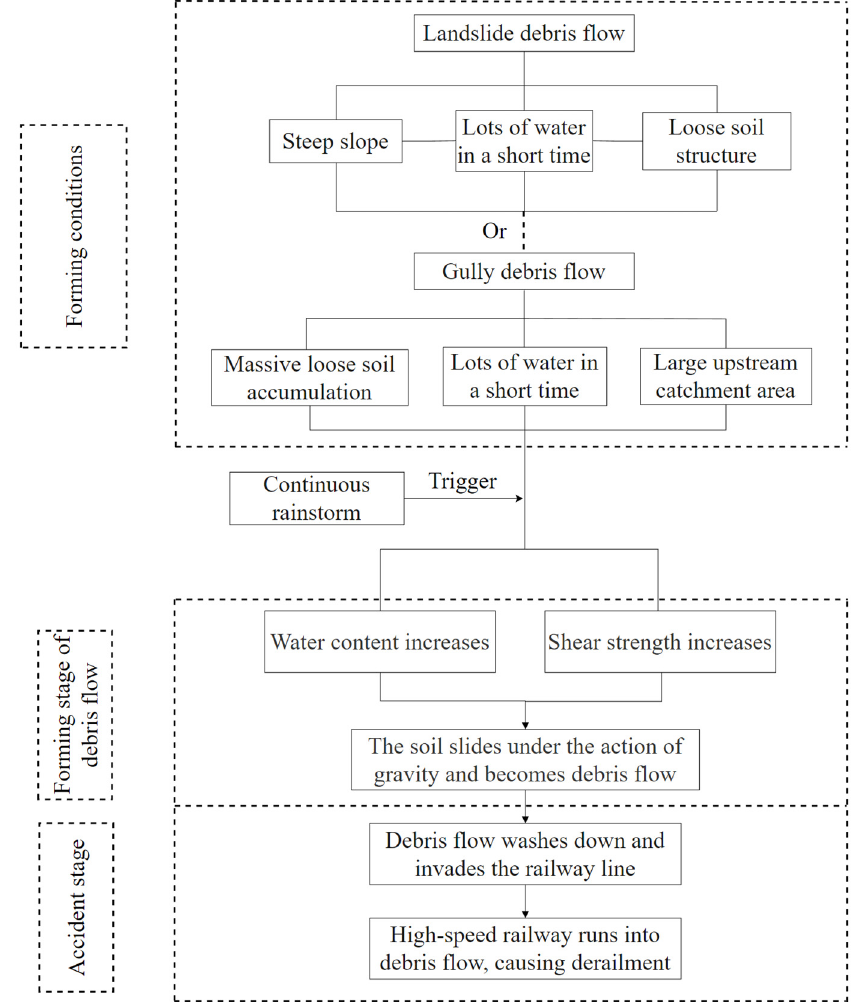
Figure 7. Logic diagram of debris flow analysis and judgment that caused this derailment